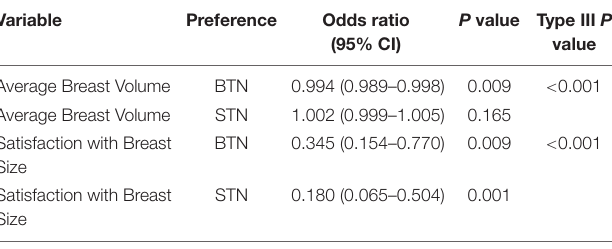
TABLE 2 | Two-covariate Multivariable Multinomial Logistic Regression